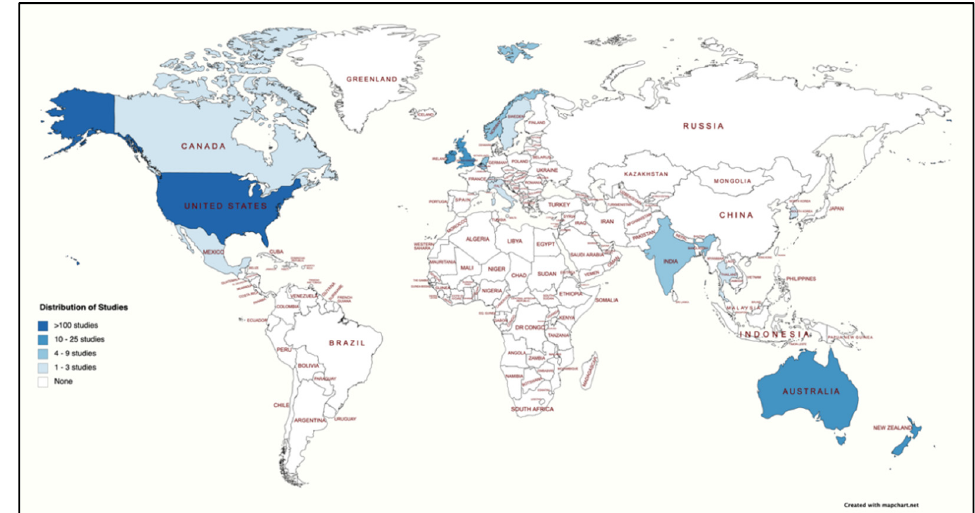
Figure 3. Frequency distribution of article types (Sum of percentages is not equal to 100% due to rounding).